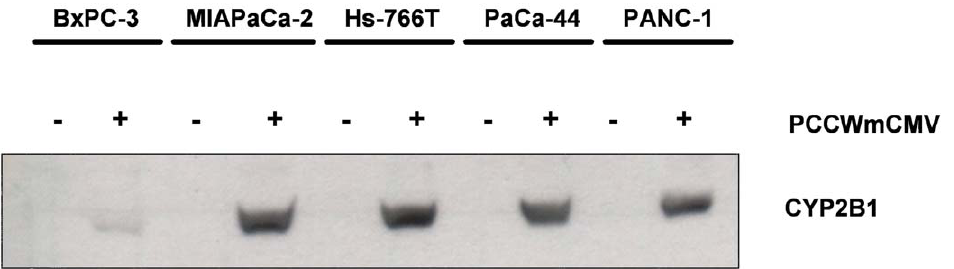
Figure 4. Cytochrome 2B1 protein expression in PCCWmCMV-transduced and non-transduced parental cell lines. Total cellular lysates from 8 6 10 5 cells were separated on a 10% polyacrylamide gel under denaturing conditions. After blotting, CYP2B1 protein was detected with a CYP- specific antibody.